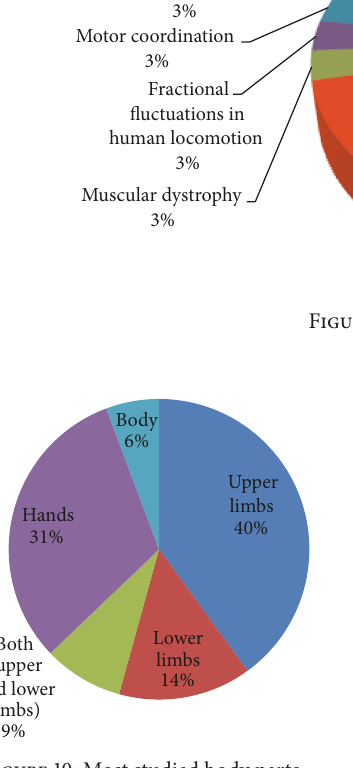
Figure 10: Most studied body